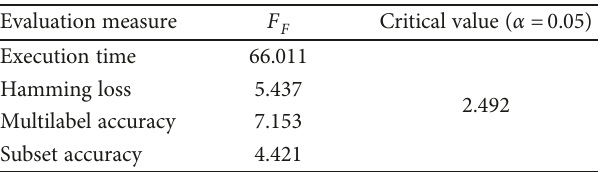
Table 6: Summary of the Friedman statistics F the critical value in terms of each evaluation